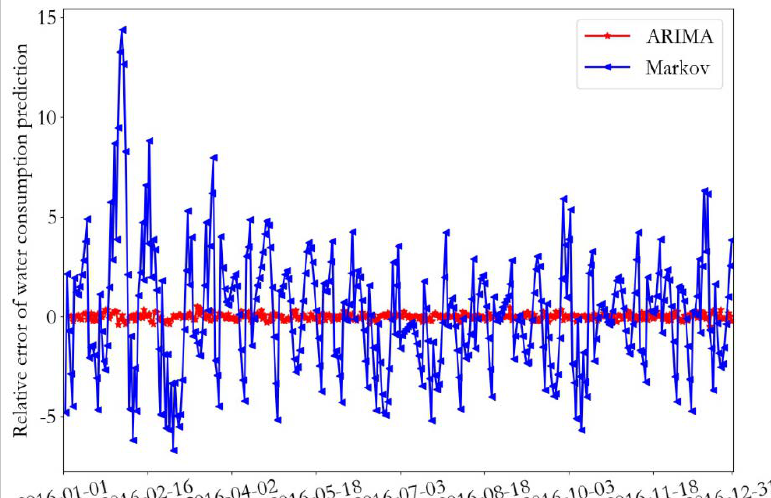
Figure 14. Prediction results of the training data at monitoring point 2.